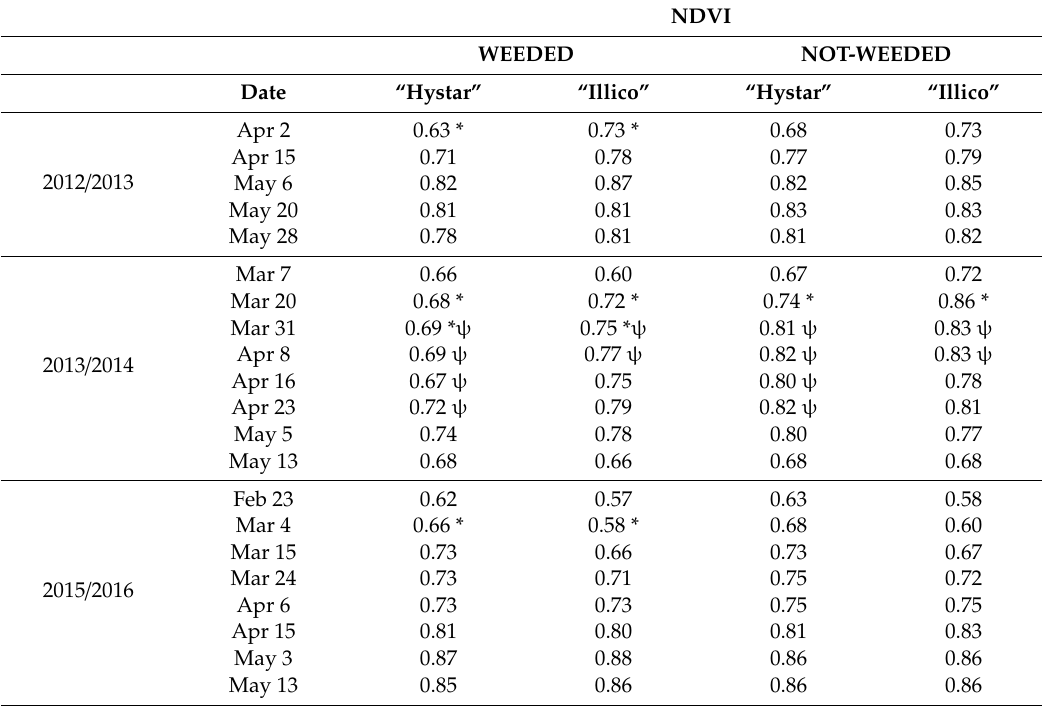
Table 10. Normalized Di ff erence Vegetation Index (NDVI) values recorded at Cigliano in the period 2012–2013, 2013–2014 and